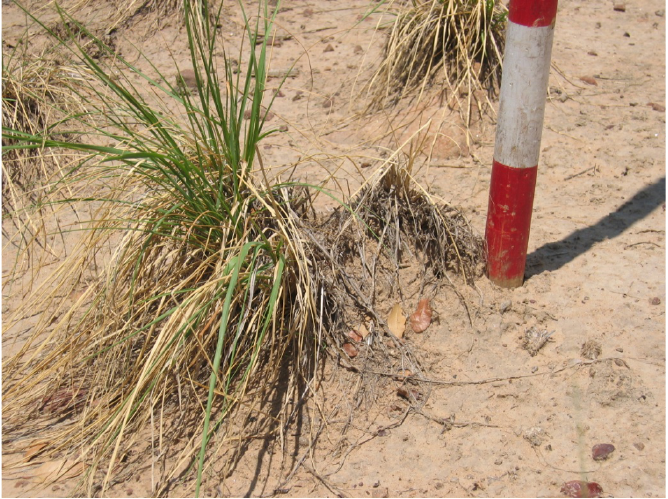
Figure 8. Weeping lovegrass bunch with a “pedestal” appearance in a burned area of the Dude